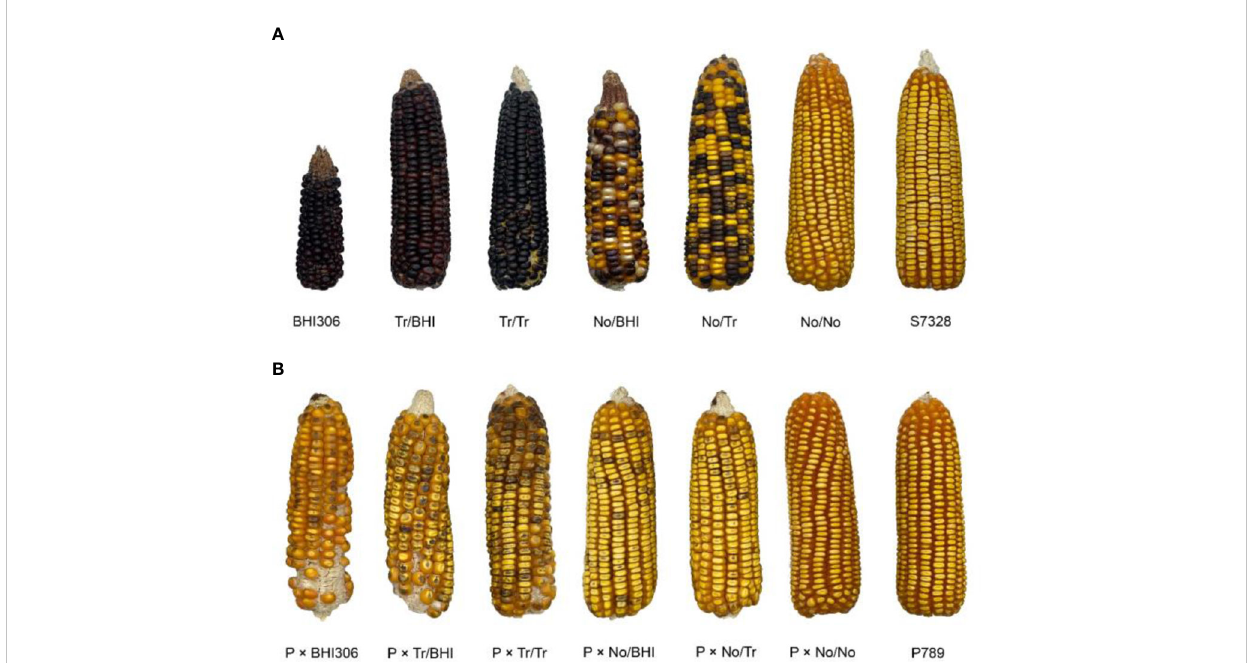
FIGURE 4 The expression of kernel R1-nj anthocyanin marker in pollinator ears (A) and donor genotype P789 pollinated with respective pollinators (B) . List of pollinator genotypes from left to right: inbred inducer BHI306, KHI54 × BHI306 (representative of Tr/BHI group), KHI47 × KHI49 (representative of Tr/Tr group), Takfa1 × BHI306 (representative of No/BHI group), S7328 × KHI47 (representative of No/Tr group), and Takfa1 × S7328 (representative of No/No group). Genotypes S7328 and P789 were used as negative checks for R1-nj anthocyanin marker in pollinators (A) and induced donor ears (B) ,